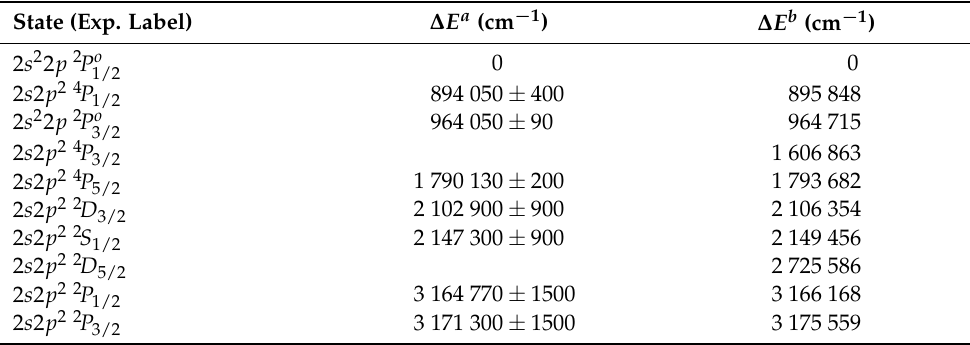
Table 8. Experimental and computed excitation energies for Mo